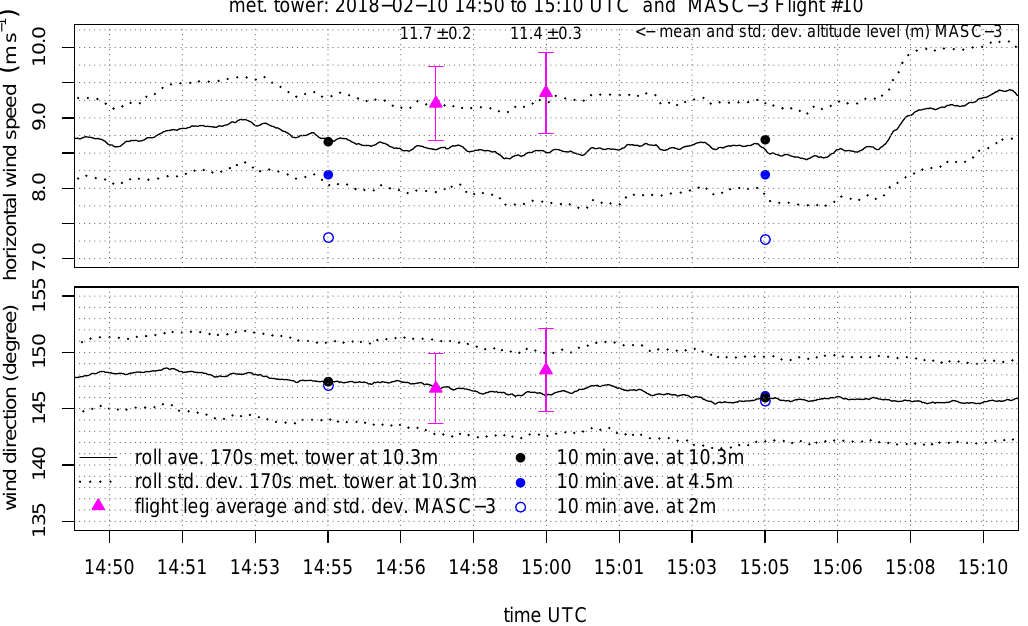
Figure 10. Time series of the tower with the corresponding leg averages and standard deviation of MASC-3 at the lowest flight levels for the horizontal wind v h ( top ) and the wind direction φ ( bottom ). The mean altitude and standard deviation of the individual flight leg is given for the MASC-3 data points. The data of the tower at 10.3 m is plotted as rolling (moving) average with standard deviation and a window length of ∆ t tower = 170 s corresponding to the fetch of the MASC-3 flight legs with an average duration of ∆ t UAS = 80 s. Furthermore the neighboring ten minute averages of the tower at all height levels are